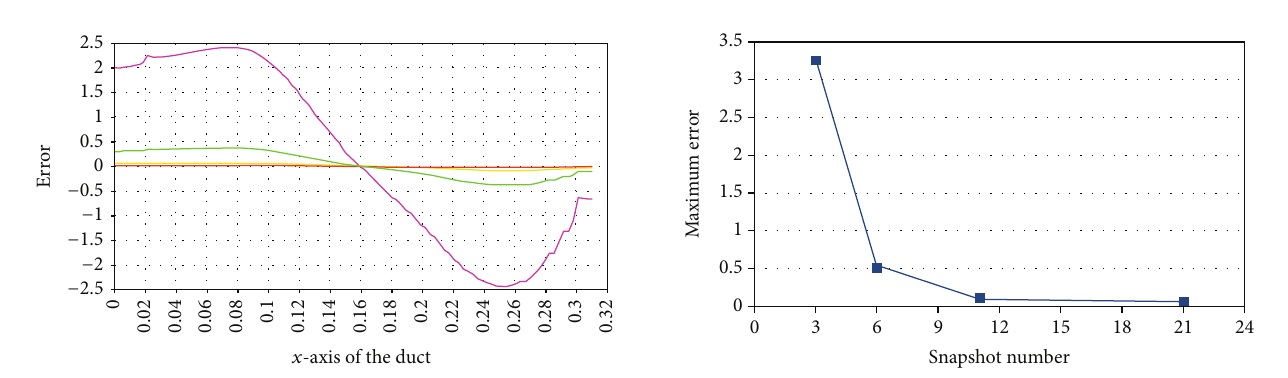
Figure 7: Backward facing step. 𝑝−𝑝 POD along the duct center line, for 3 (violet line), 6 (green line), 11 (yellow line), and 21 (red line) snapshots.